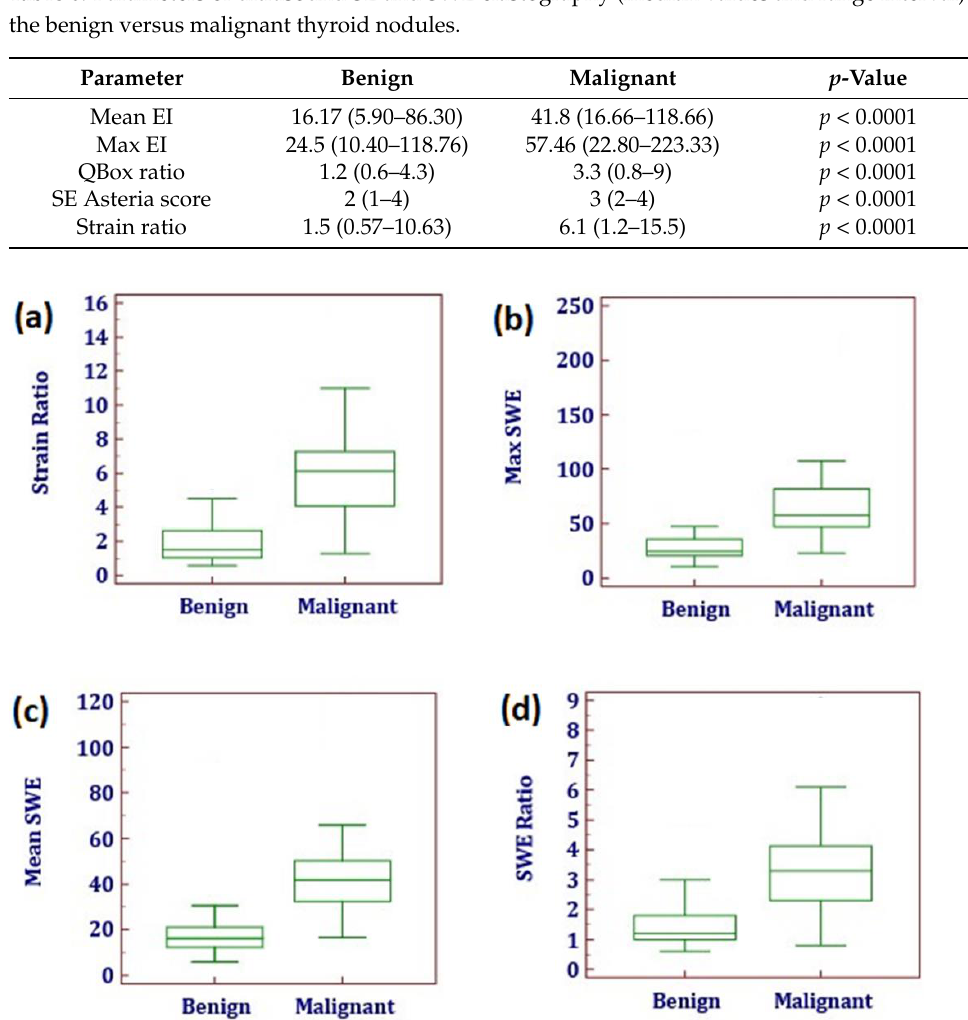
Figure 7. The distribution (box plot) of elastography parameters in patients with benign vs. malignant histopathology results for strain elastography: ( a ) strain ratio (Asteria score could not be represented as box plot); for shear-wave elastography: ( b ) Max elasticity index (Max SWE) measured in kPa; ( c ) Mean elasticity index (Mean SWE) measured in kPa; ( d ) QBox ratio (SWE ratio).